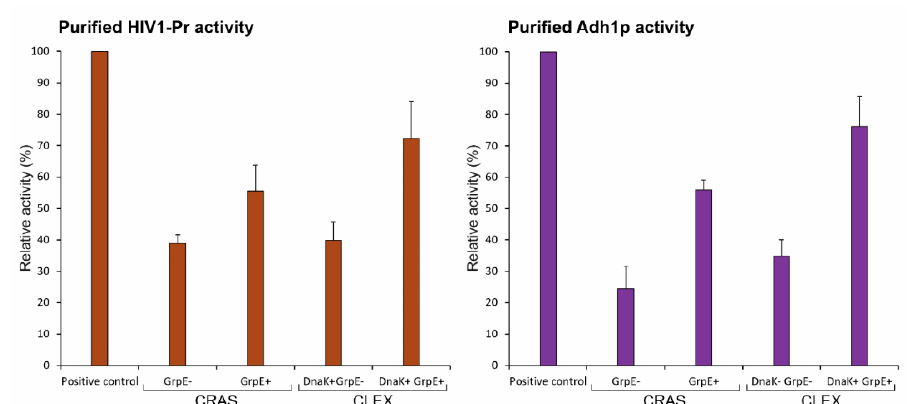
Figure 5. In vitro activities of purified ( A ) HIV-1 protease and ( B ) Adh1p expressed using CRAS and CLEX systems in the absence and presence of GrpE or GrpE and DnaK. His-tagged HIV-1 protease and Adh1pwerepurifiedusingNi-IDAresinfrom1lculture. Positivecontrolsarethecommerciallyavailable purified HIV-1 protease and Adh1p. Error bars show ± S.D. from three independent